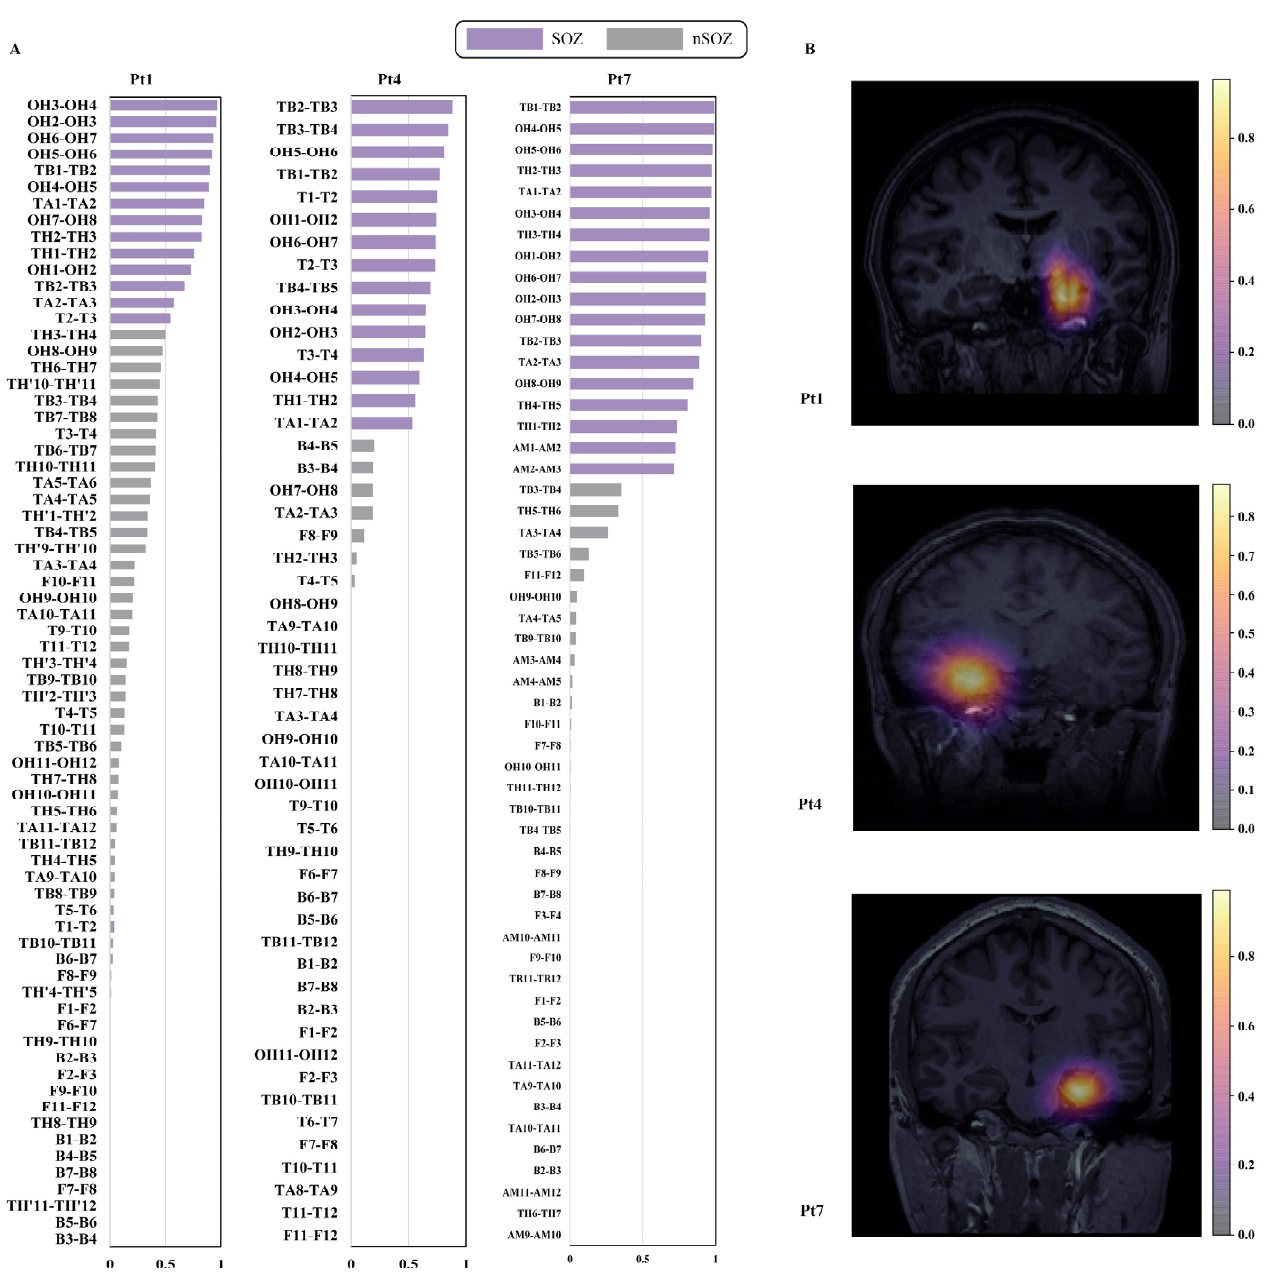
Figure 5. Bar-plot and MRI prediction probability for three patients: ( A ) bar-plot of contact prediction probability. X-axis and y-axis show prediction probability and contact name. Purple contacts are SOZ, while gray contacts are nSOZ; and ( B ) three patients’ predictive MRI.